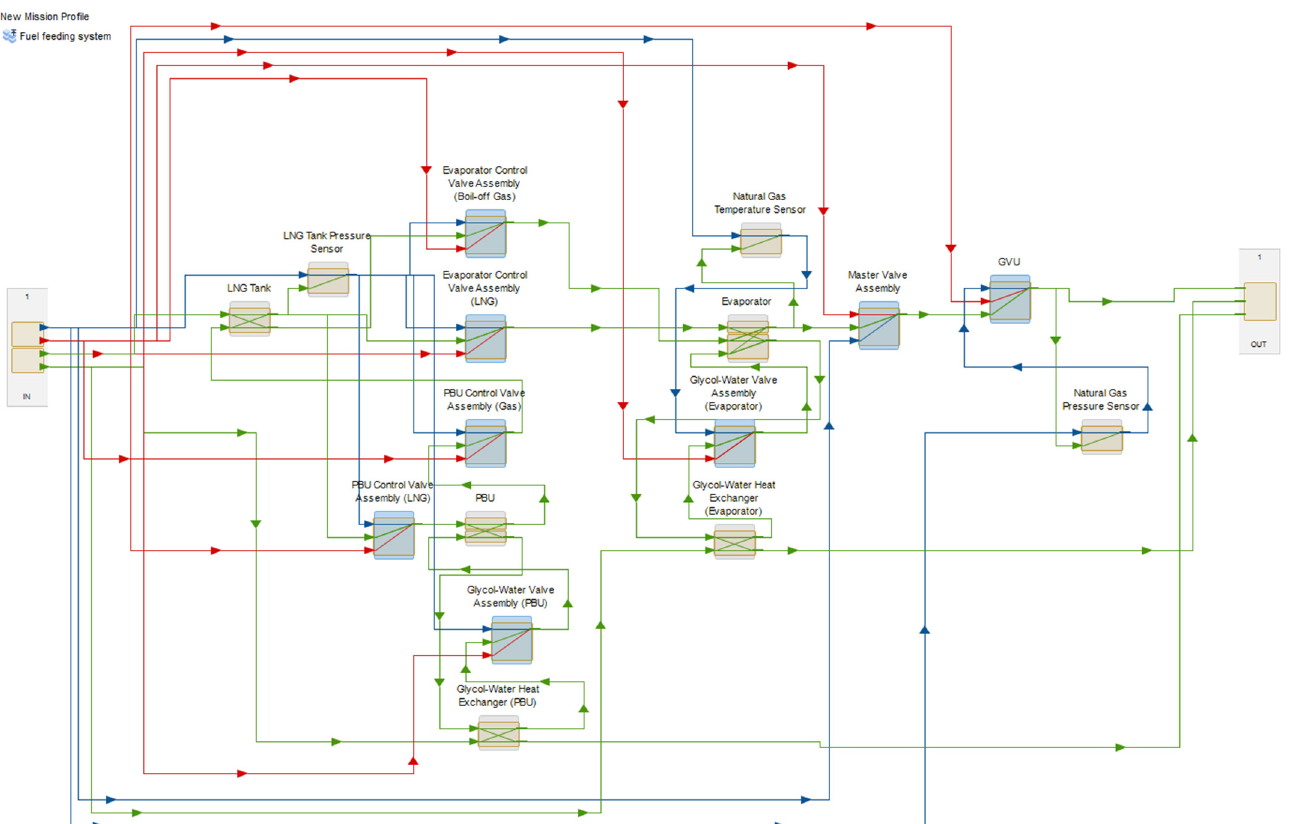
Figure 5. LNG fuel system functional model in